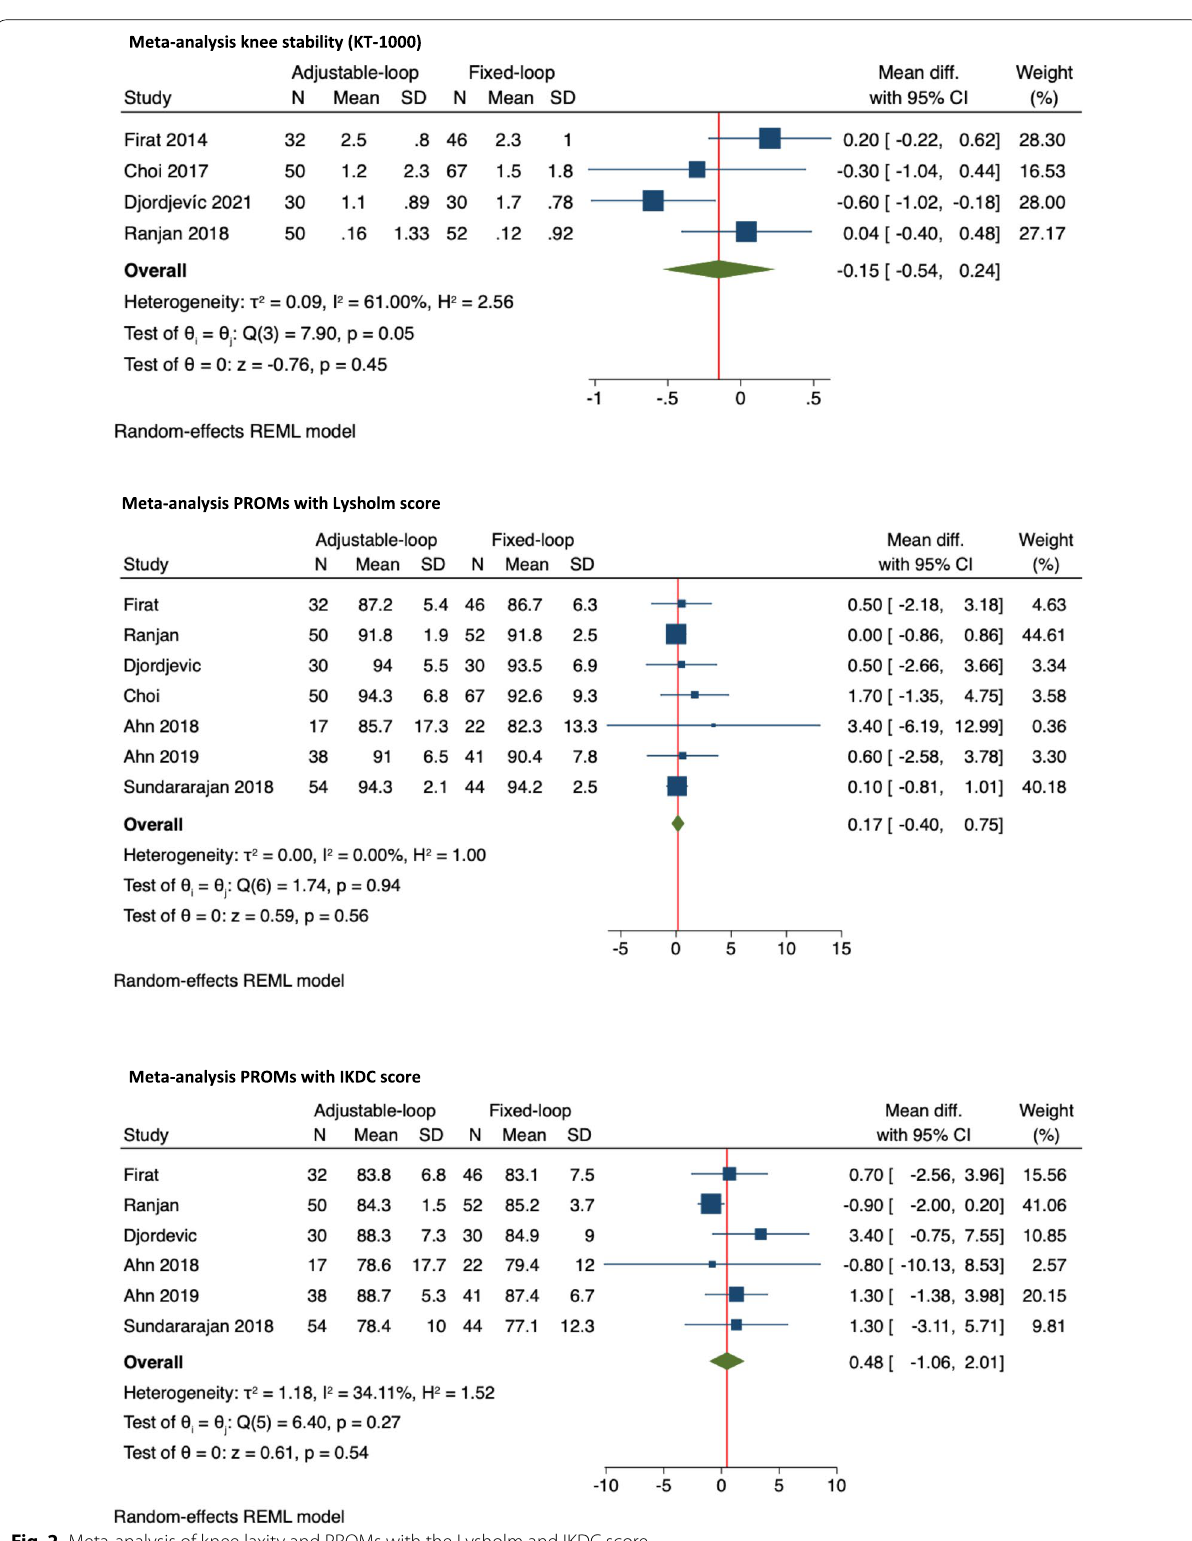
Fig. 2 Meta-analysis of knee laxity and PROMs with the Lysholm and IKDC